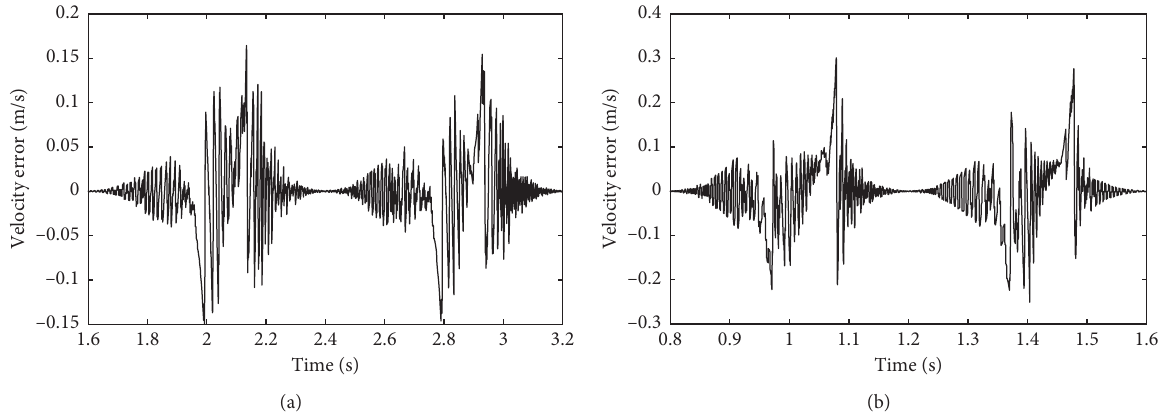
Figure 17: Velocity error of the slider. (a) ω